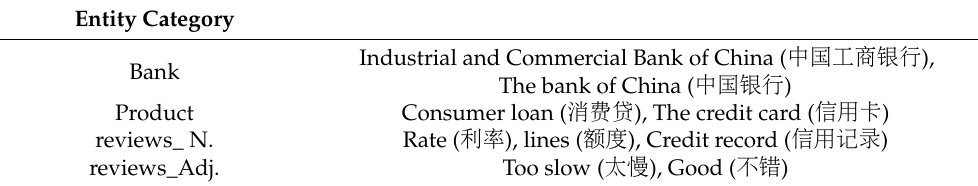
Table 2. Examples of product entity